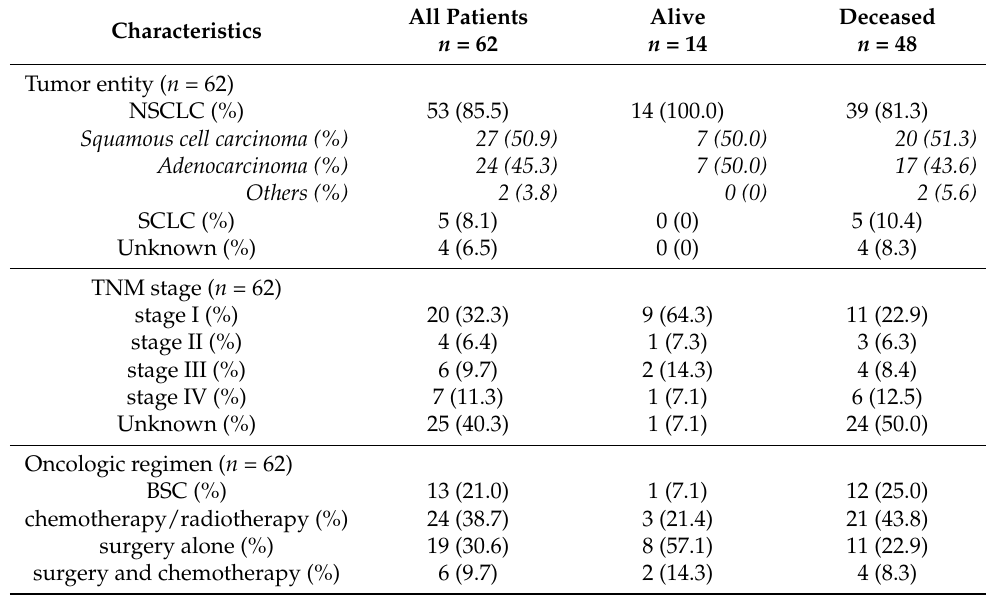
Table 2. Tumor characteristics and treatment .